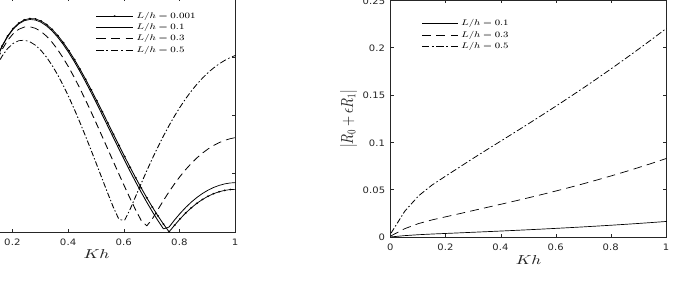
Figure 7. | R 1 | for different plate lengths with M = 1 ,c 0 /h = 0 . 1 ,l 1 /h = 0 . 01 ,D/h 4 = 1.